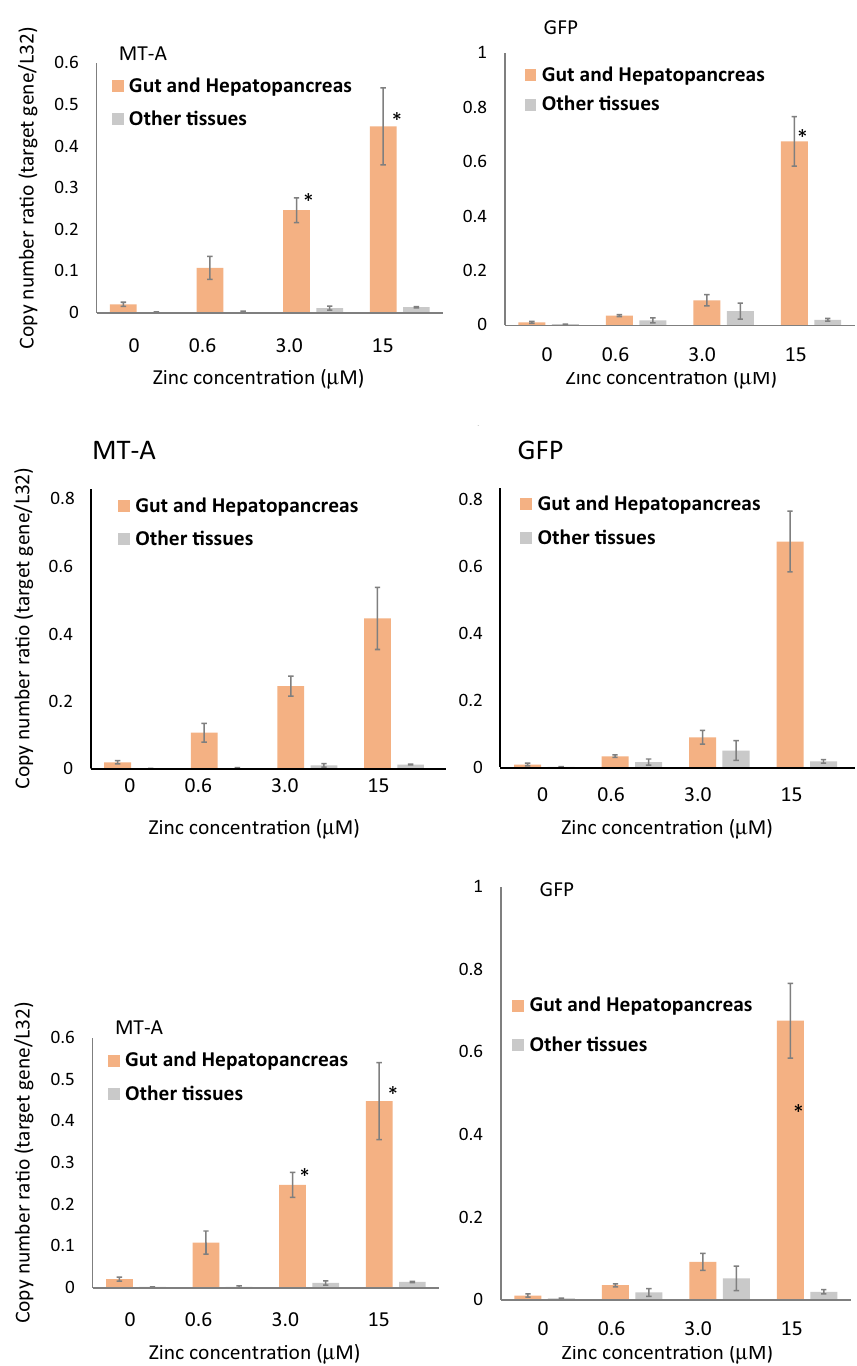
Figure 3. Tissue-specific MT-A and GFP expressions. Neonatal Daphnia (< 24 h) were exposed to different concentrations of Zn 2+ for 24 h. Midgut and hepatopancreas of D. magna MetalloG were dissected and mRNA was purified. mRNA was also purified from the remaining tissue. The mRNA expression levels of MT-A and GFP were estimated by qPCR. Relative amounts of mRNA to that of the ribosomal L32 protein gene were estimated by ΔΔCτ method and indicated in Y-axis. The quantification was performed three times. Bar =